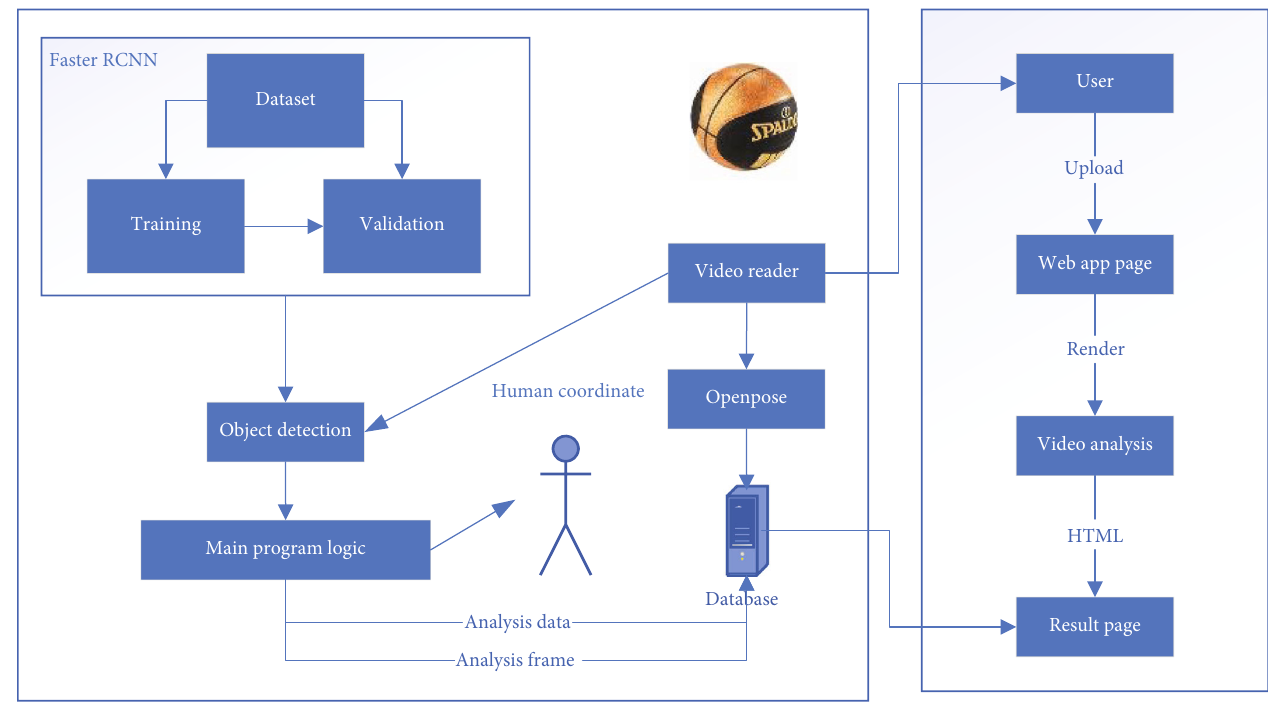
Figure 4: System structure of basketball technical and tactical analysis